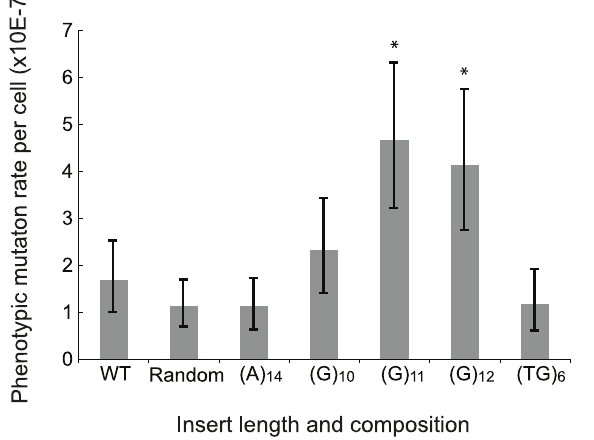
Figure 7. Insertion of repeat sequences upstream of URA3 increases the mutation rate to Ura 2 . 12-nucleotide insertions were engineered four base pairs upstream of URA3 . Mutation rates of different insertions were determined by fluctuation test using at least 10 cultures. Data represent the mean of three repeats. The strain denoted as wt has no insertion and that designated as random has a non-repeat 12-nucleotide insertion (see Materials and Methods for the sequence). Error bars represent 95% confidence intervals. Significance was calculated using t tests, and asterisks indicate p , 0.001.